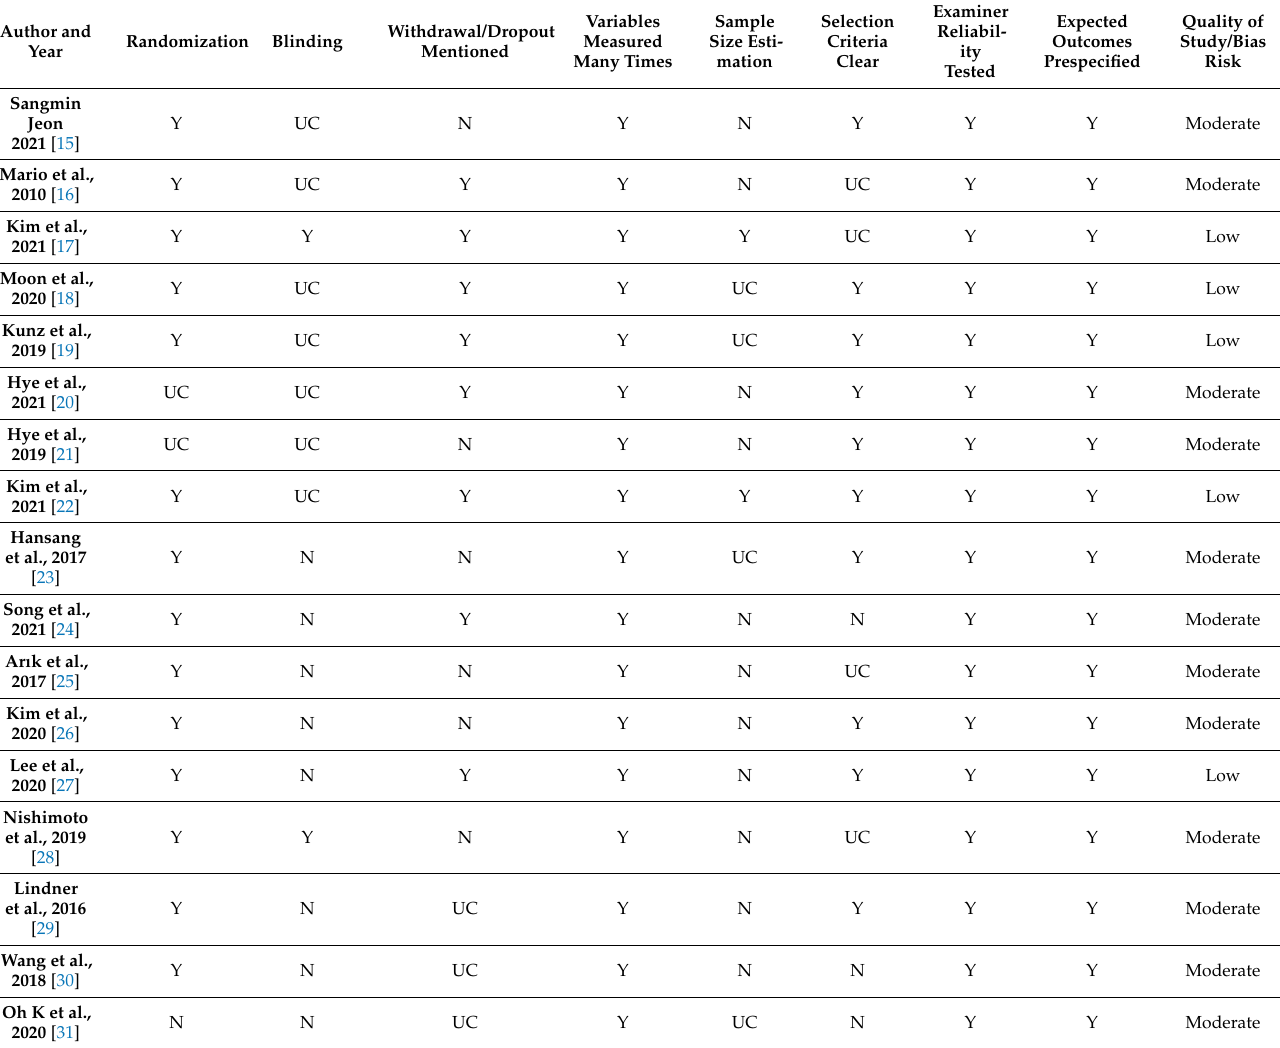
Table 2. Methodological quality assessment results of the included studies ( n =